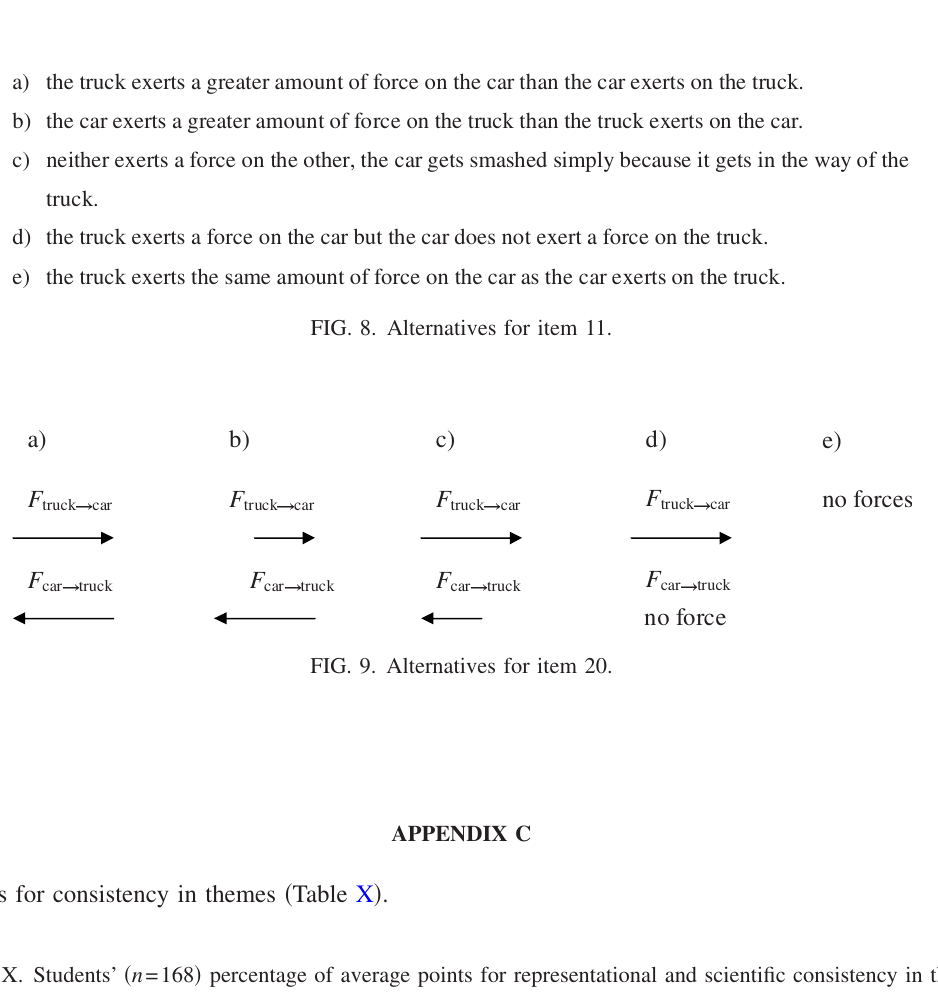
FIG. 7. Alternatives for item 2.